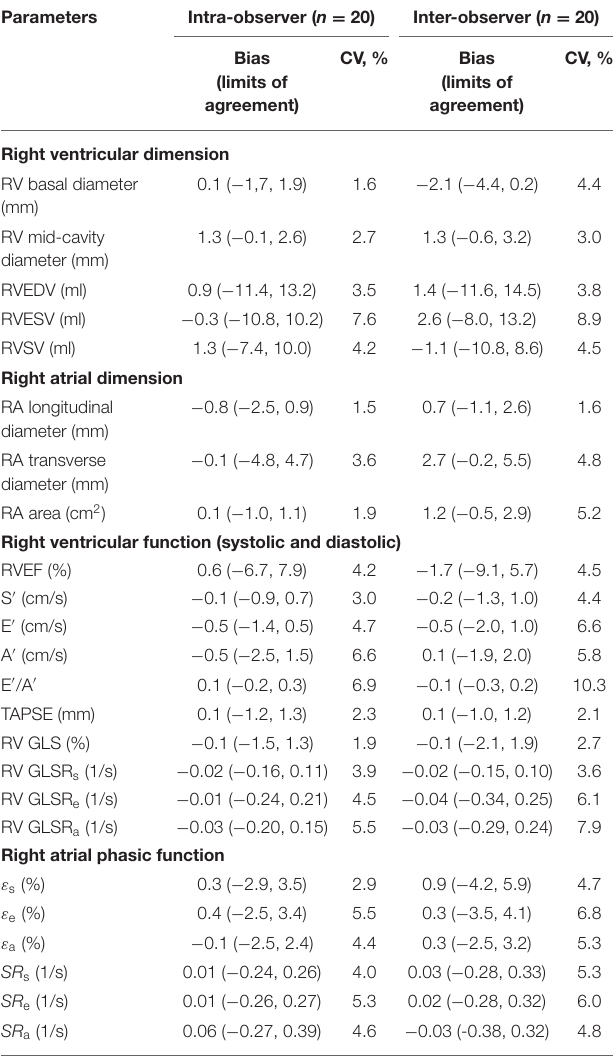
TABLE 4 | Intra- and inter-observer reproducibility for right heart dimension and function parameters.